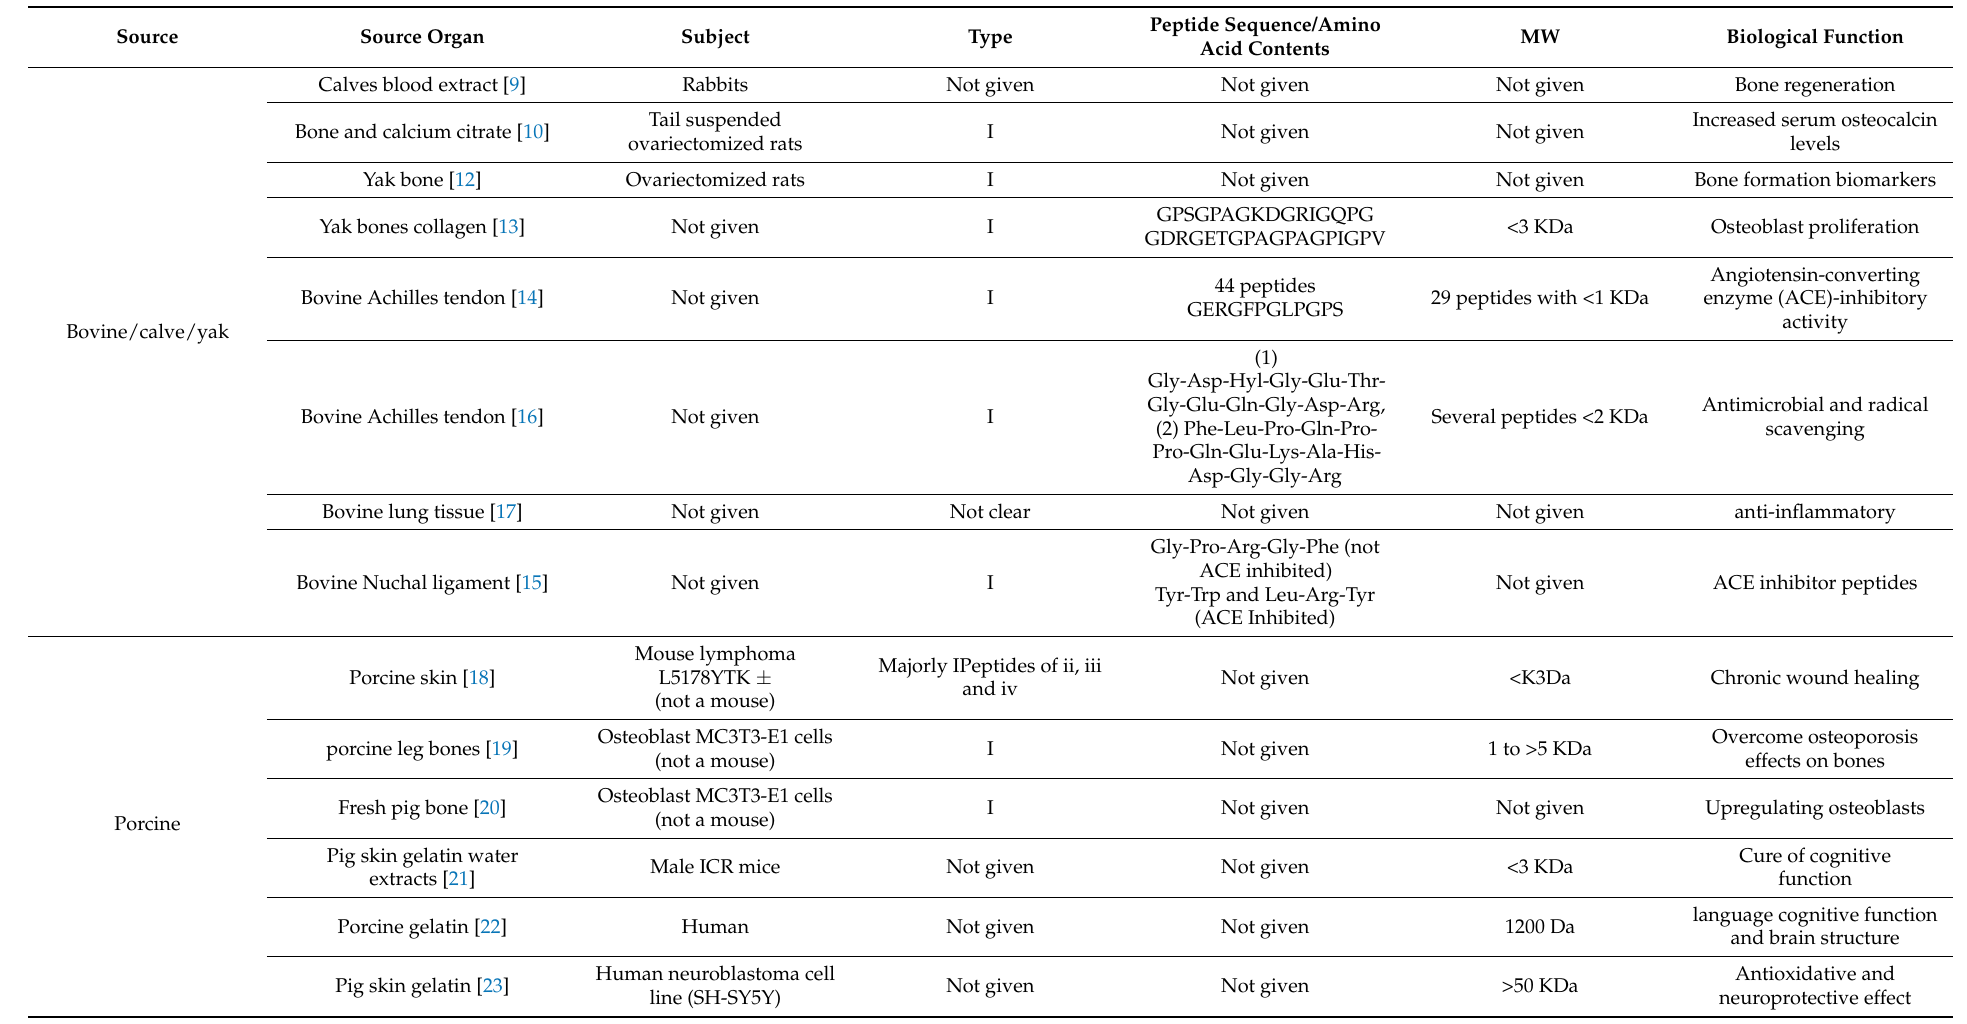
Table 1. Literature regarding